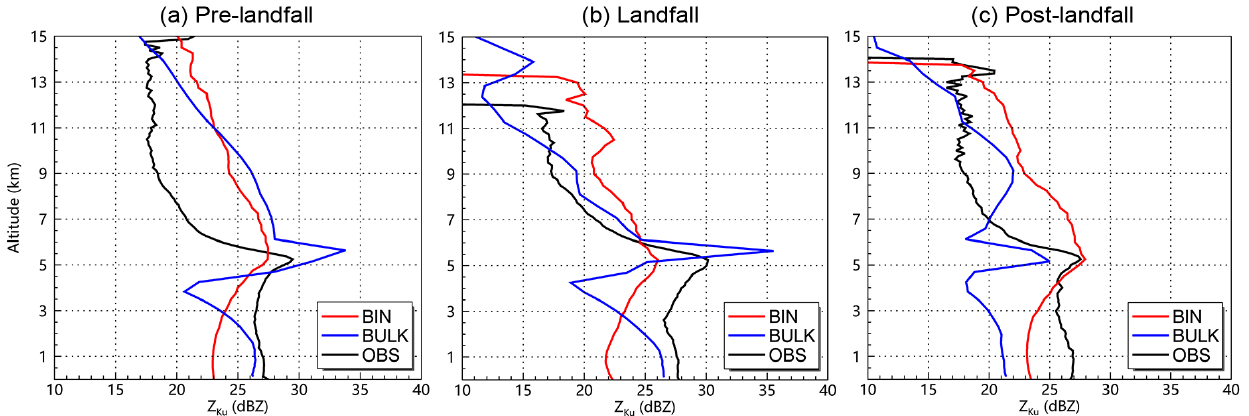
Figure 8. Domain-averaged vertical profiles of attenuation-corrected radar reflectivity ( Z ku ) derived from both GPM DPR observation and WRF model simulation for Typhoon In-Fa (2021) during three different landfall periods. Note only the grid points with reflectivity are considered, and those grid points with no-reflectivity are ignored. The Ku-band radar reflectivity is calculated via Equation (4) in Wu et al. [2].